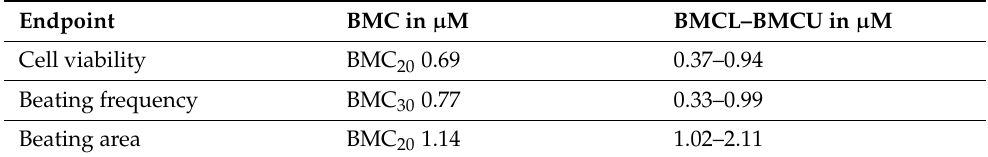
Table 2. Benchmark concentration (BMC) values including the Benchmark concentration lower limit (BMCL) and Benchmark concentration upper limit (BMCU) calculated with the respective Benchmark response (BMR) for the substance